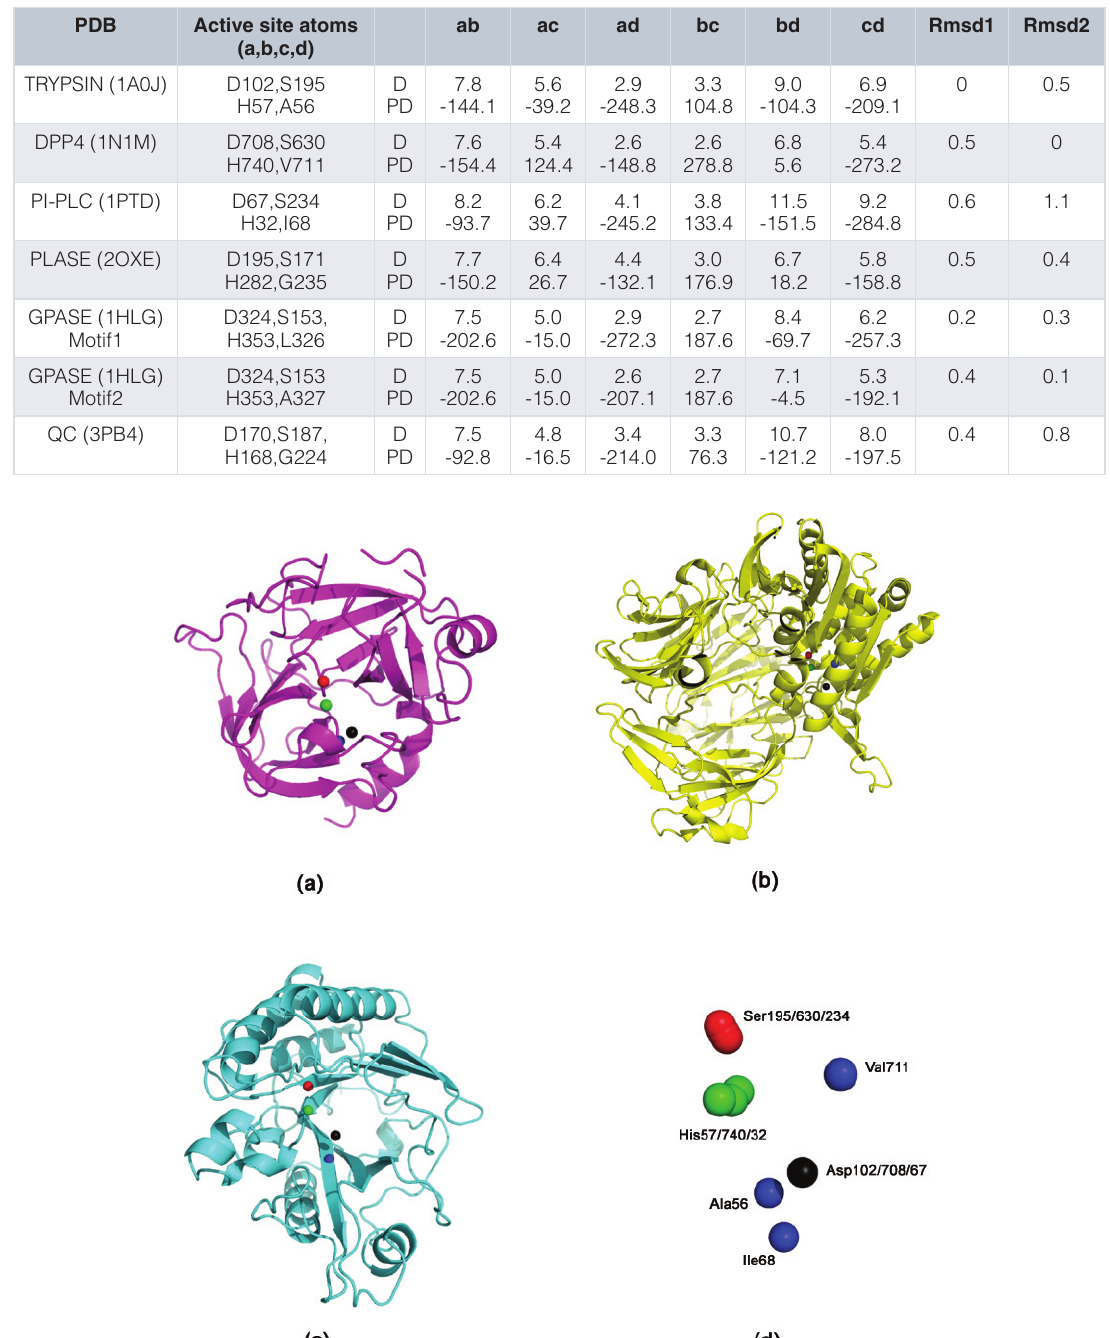
Table 1. Potential and spatial congruence of the active site residues in proteins queried using two motifs - Motif1 from Trypsin and Motif2 from DPP4. Rmsd1 and Rmsd2 are the root mean square deviation of the scaffold with respect to Motif1 and Motif2. DPP4 - dipeptidyl peptidase-IV, PI-PLC - phosphoinositide-specific phospholipase C, PLASE - human pancreatic lipase-Related Protein 2, GPASE - human gastric lipase, QC - glutaminyl cyclase. D = Pairwise distance in Å.